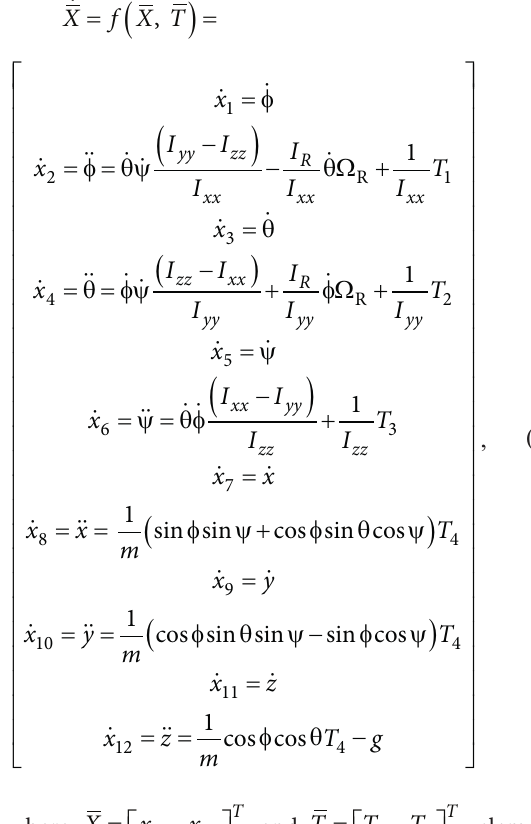
Fig. 9. Angle of rotation ψ( t ) about the OZ -axis